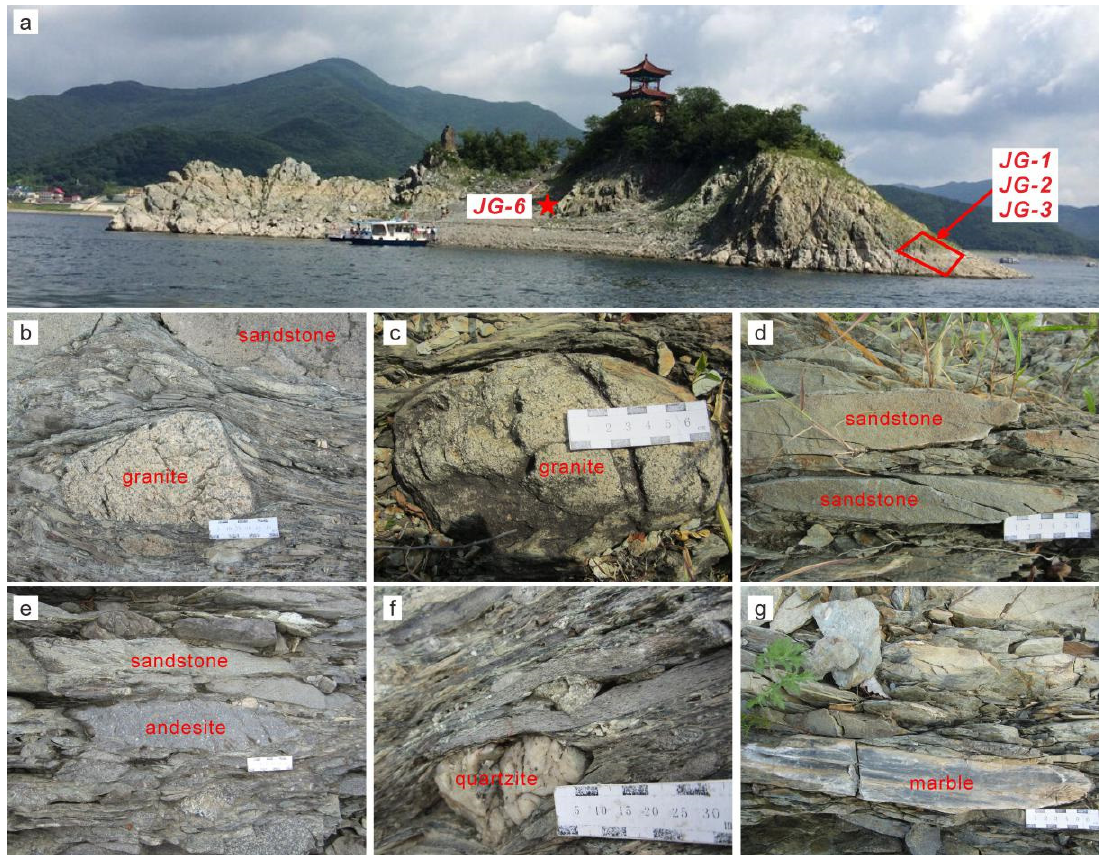
Figure 3. Field photographs of the Jin ′ gui Island showing ( a ) the sample locations and ( b – g ) different types of pebbles in the conglomerate.